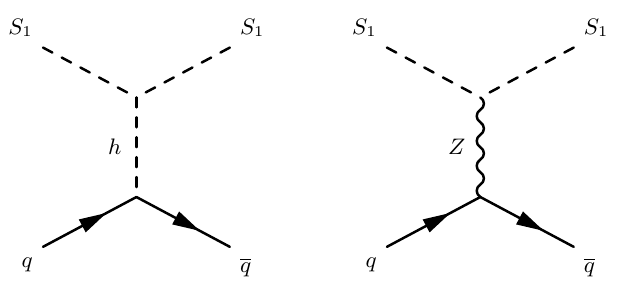
Figure 10 . Tree-level diagrams contributing to WIMP-nucleon spin-independent elastic cross- section for scalar